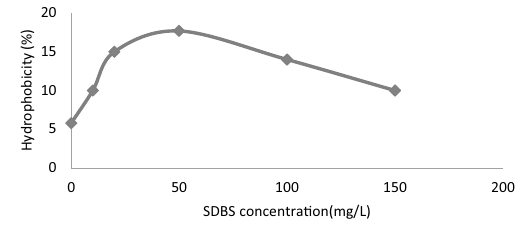
Fig. 3 Effect of SDBS concentration on